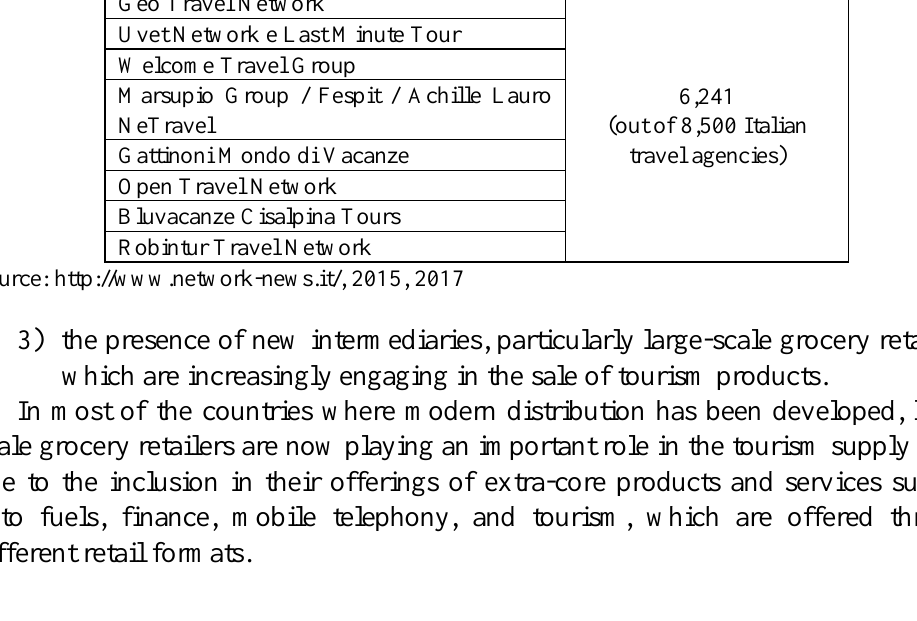
Table 2: The 8 major tourism retail Groups (macro-aggregations) in Italy Groups Total No. of